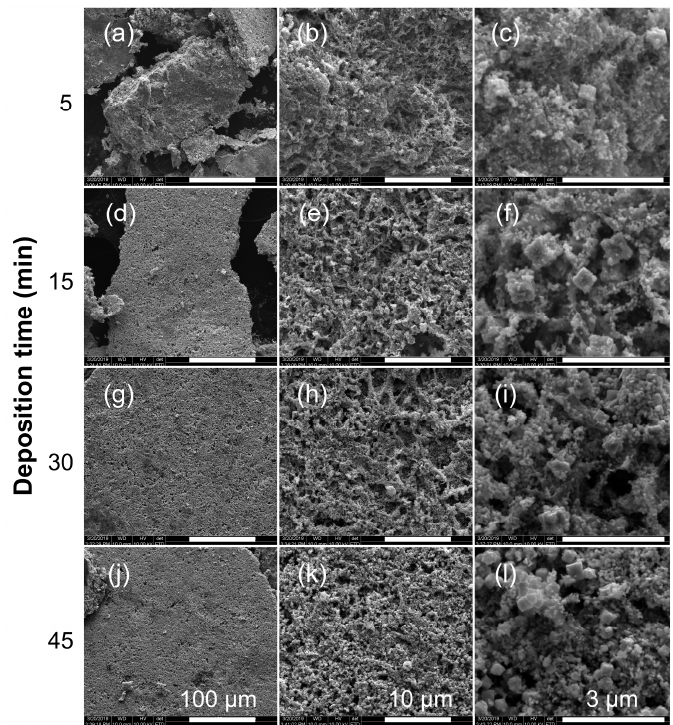
Figure 2. Representative SEM images of electroless Cu-SWCNT composites deposited (at a bath temperature of ~90 °C) at different reaction times with resulting SWCNT composition: ( a – c ) 5 min., 10.6 wt.% SWCNTs; ( d – f ) 15 min., 8.33 wt.% SWCNTs; ( g – i ) 30 min., 7.2 wt.% SWCNTs; ( j – l ) 45 min.,